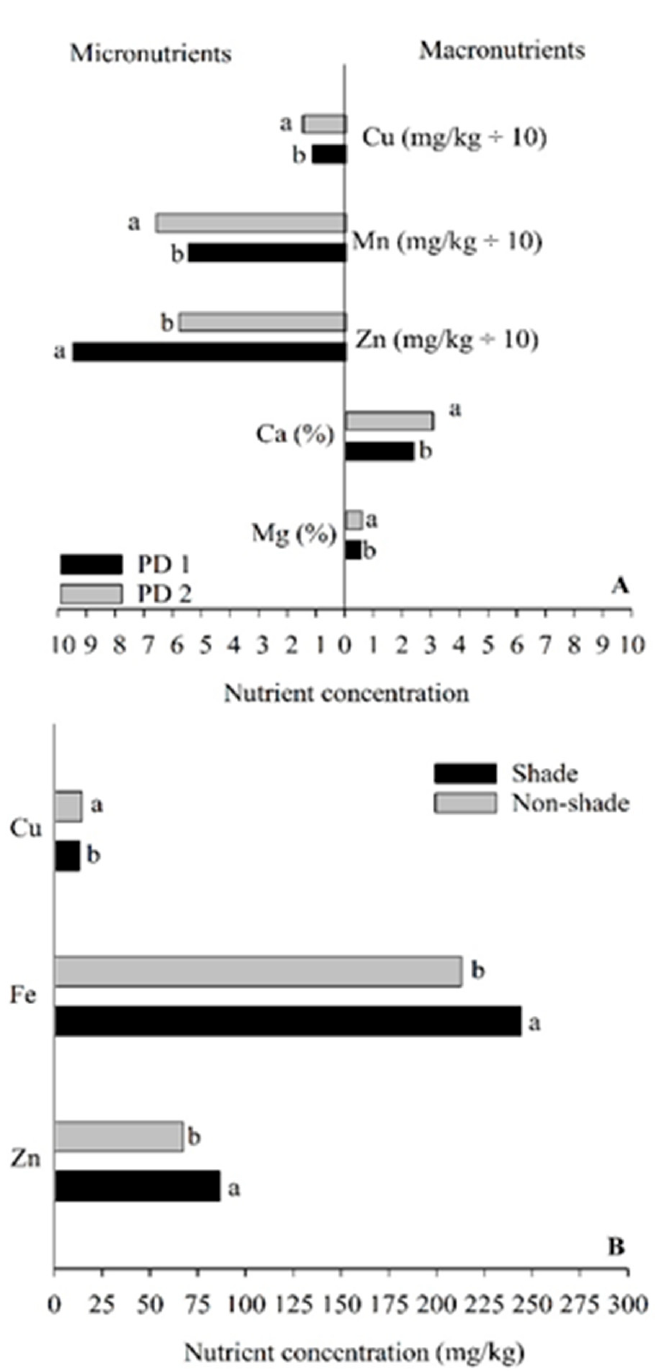
Figure 3. Main effects of planting date (PD) ( A ) and shade cloth ( B ) on the dry weight concentrations of copper (Cu), manganese (Mn), zinc (Zn), calcium (Ca), magnesium (Mg), and iron (Fe) in high tunnel-grown basil. Columns followed by the same letter(s) are not significantly different according to Tukey’s Honest Significant Difference Test ( p < 0.05).